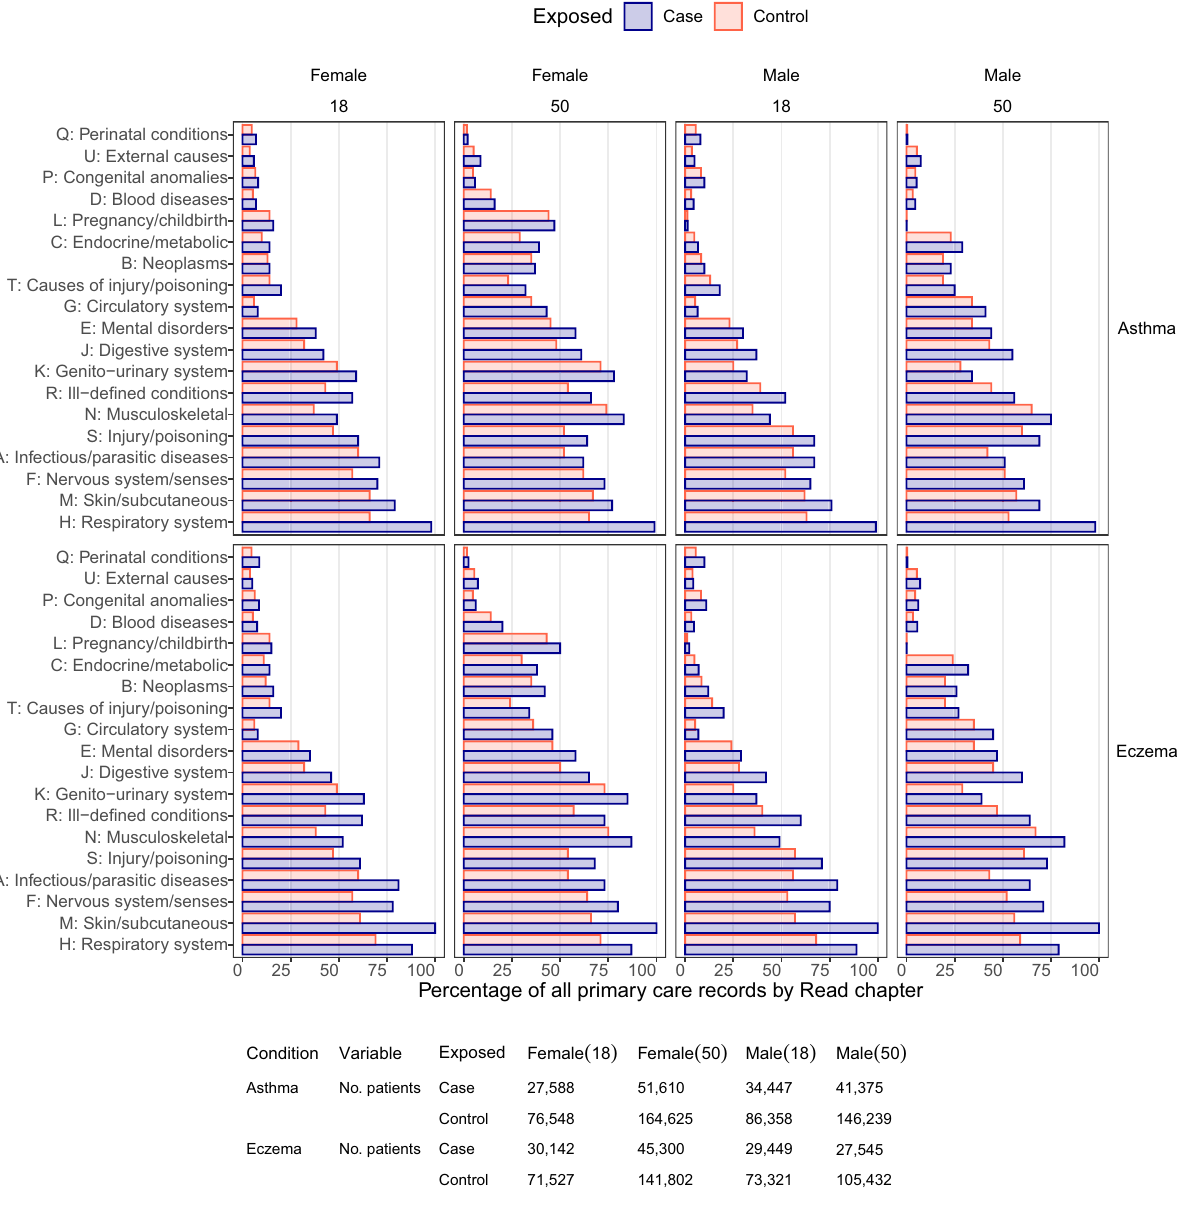
Figure 1. Proportion of people with asthma (top 4 graphs) and eczema (bottom 4 graphs) and their matched controls that ever recorded a diagnostic code in each Read chapter by age (18 ± 5 years, 50 ± 5 years) and